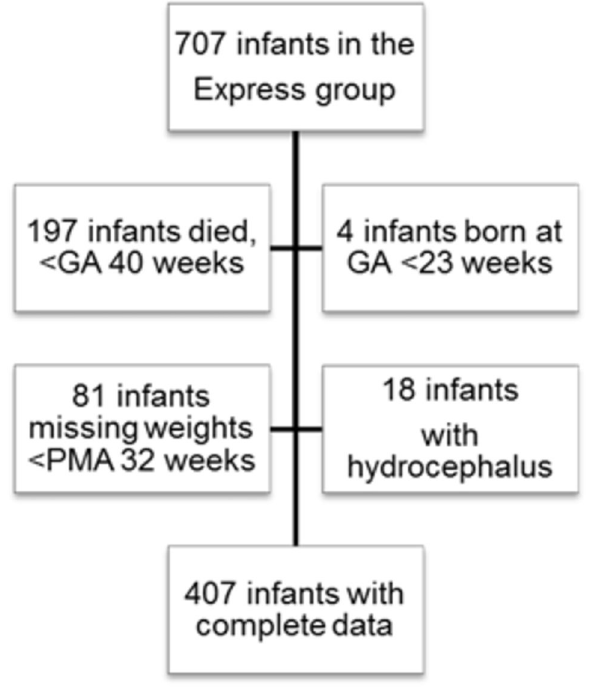
Figure 1. Flowchart of the study